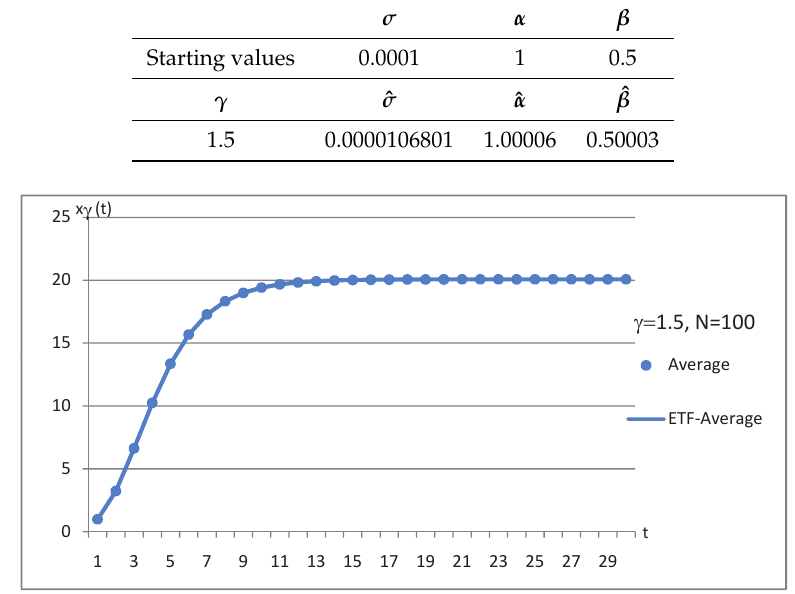
Figure 3. Fit and prediction based on ETF.